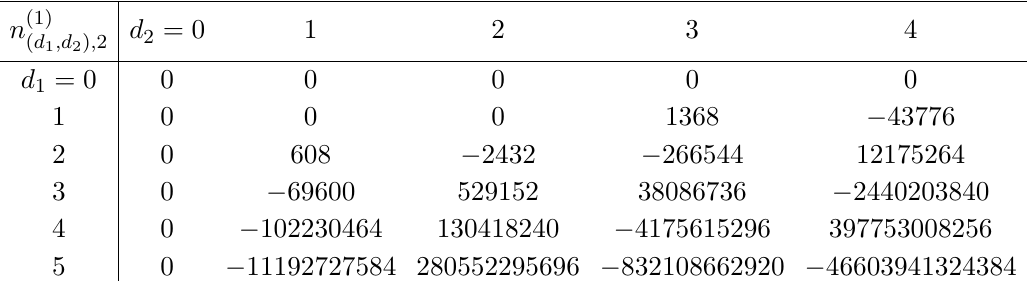
Table 24 . Genus 1 Gopakumar-Vafa invariants for X (4)